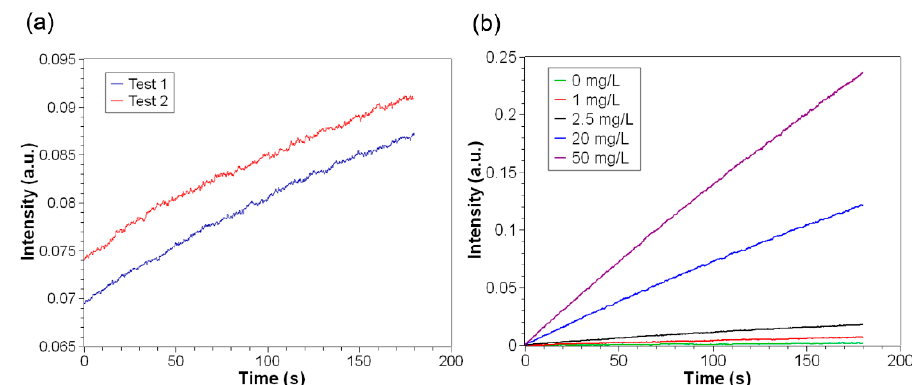
Figure 4. Intensity change of scattered light over time. ( a ) Intensity change of light in two experiments using a same CRP sample (2.5 mg/L) but different capillaries. ( b ) Intensity change of light in experiments using CRP samples with different concentrations. The curves were biased to have the same start point.